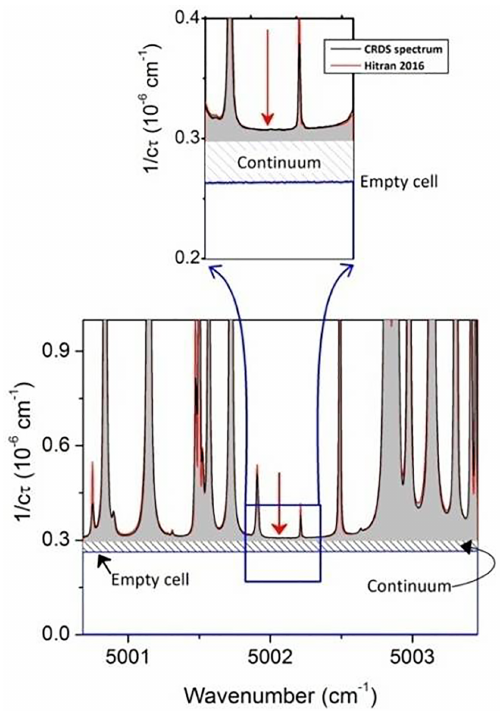
Figure 4. CRDS spectrum of water vapour between 5000.6 and 5003.5cm − 1 . The pressure was 7.0Torr at 297.35K. The red arrow indicates one of the four spectral points located in an interval free of absorption lines, which was chosen for the retrieval of the water vapour absorption continuum. The simulation performed on the ba- sis of the HITRAN2016 database (red solid line) is used to subtract the monomer contribution. The water continuum (dashed area) cor- responds to the gap between the spectrum with the monomer simu- lation subtracted and the baseline level recorded with the evacuated